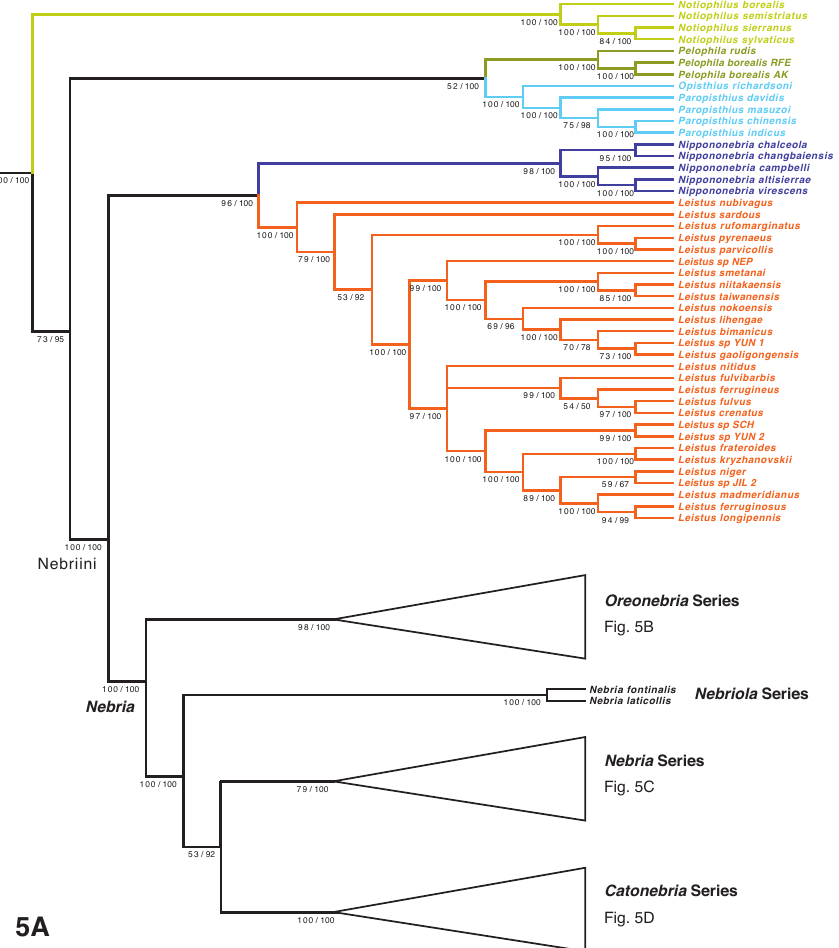
Figure 5. Majority rule consensus tree of trees from bootstrap replicates. The first number under a branch is the percentage of bootstrap replicates with that clade, the second number is the estimate of the Bayesian posterior probability of that clade expressed as a